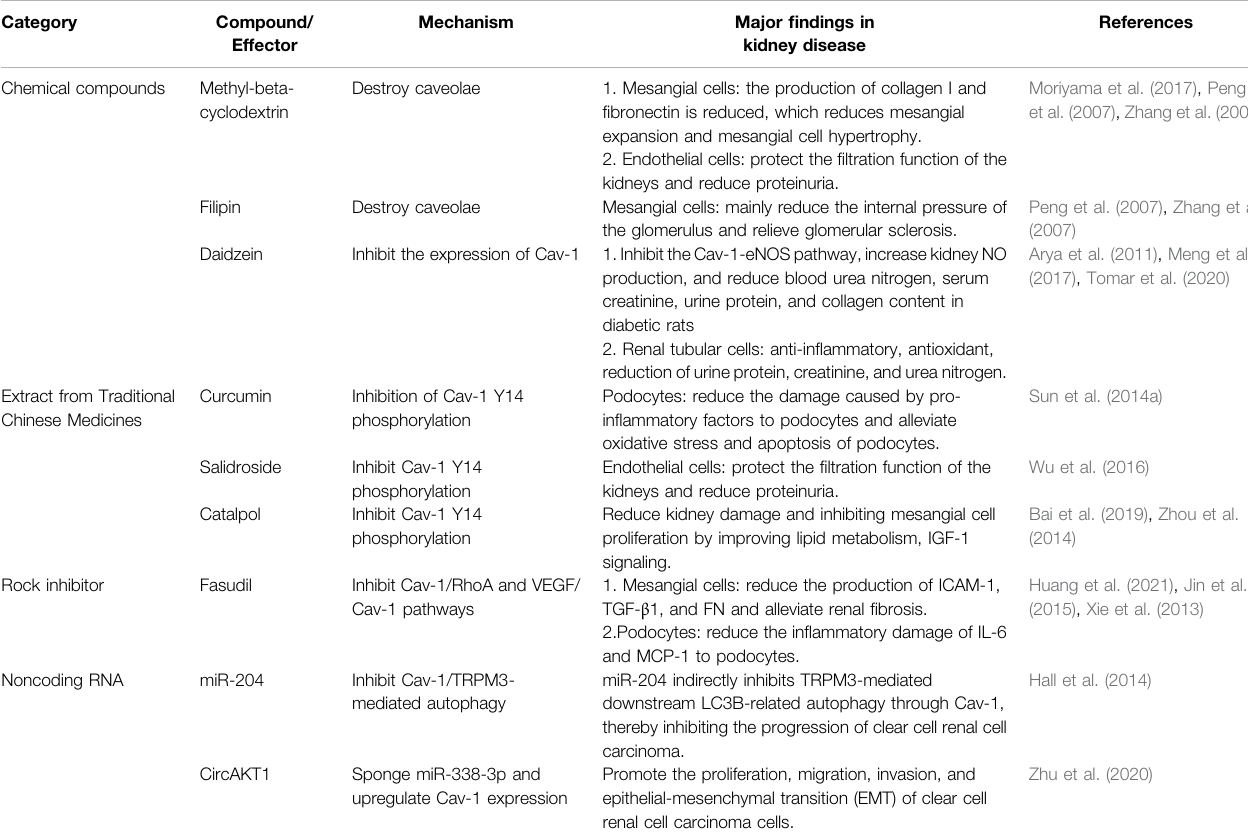
TABLE 1 | Potential therapeutic target of Cav-1 in kidney